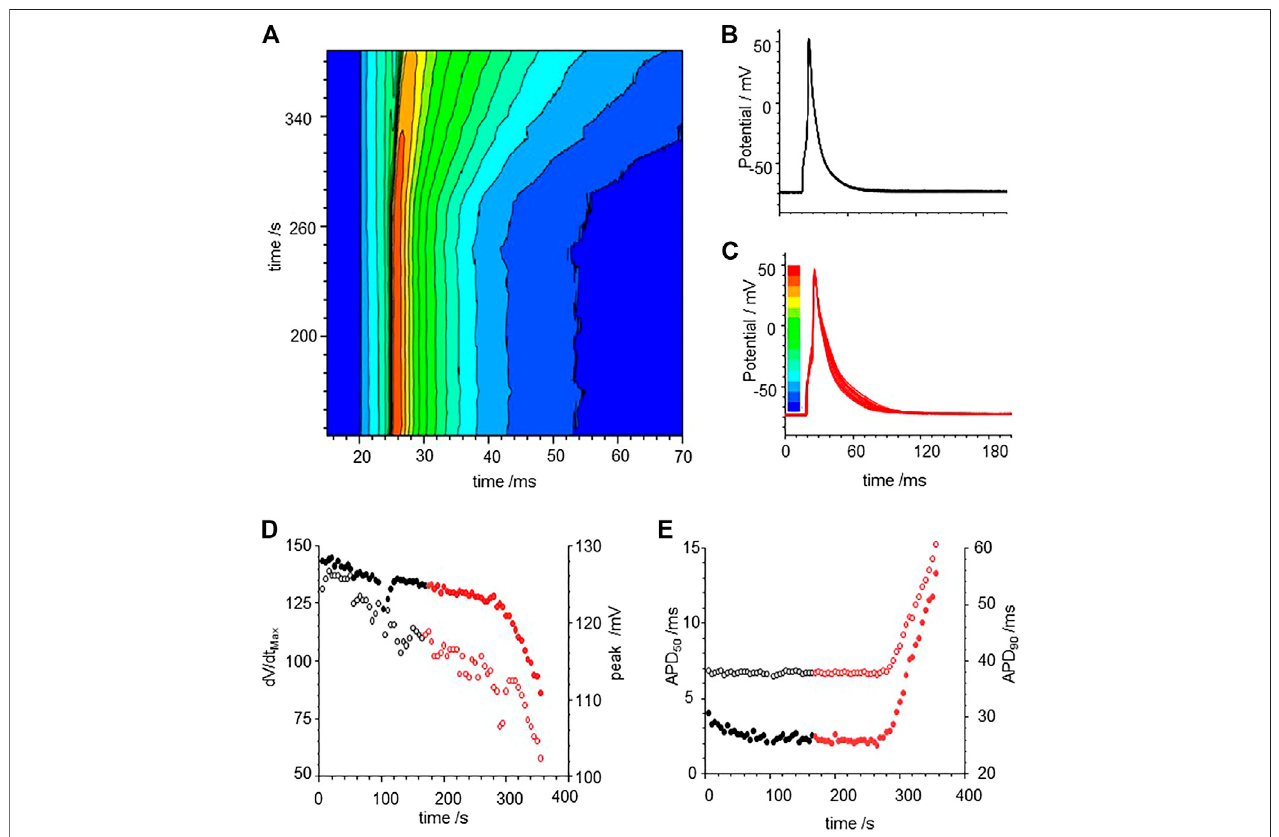
FIGURE 1 | Carbon monoxide (CO) extended action potential durations (APD) in rat ventricular myocytes. (A) color coded mapping of smooth prolongation of action potentials during 200 s of triggered activity, preceding and during perfusion of CO releasing molecule CORM-2 (10 µM). Action potential variability before (B) and after (C) exposure to CORM-2: superimposed action potentials during initial 100 s, cell was paced once every 5 s with CORM-2 added to perfusate at time 20 s, after 170 s of pacing, (D) Time series plot of peak depolarization ( fi lled symbols) and dV/dt max (open symbols). (E) Time series plot showing APD 50 (open symbols and APD 90 ( fi lled symbols) before (black symbols) and during (red symbols) exposure to CORM-2.